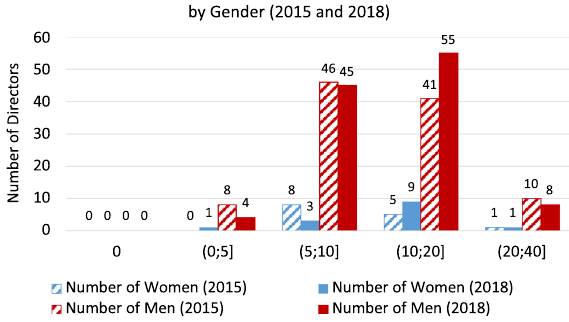
Fig. 9 Distribution of Node Degree Centrality for Directors with BC > 0 by Gender (2015 and